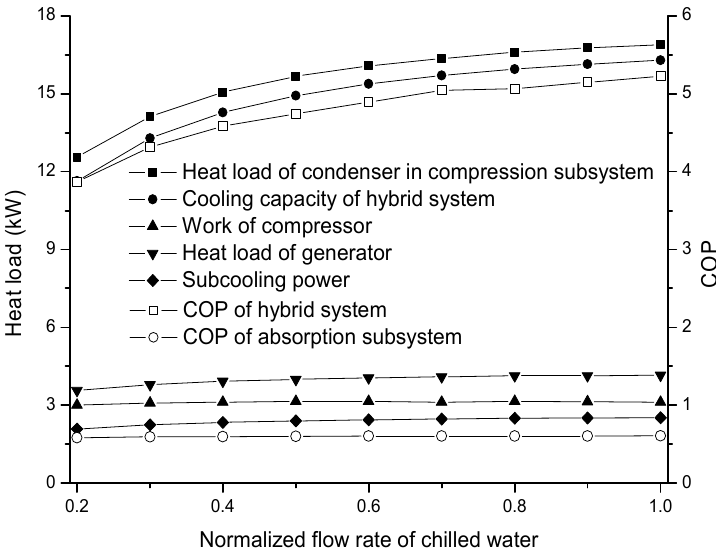
Figure 11. Performance with the flow rate of chilled water.